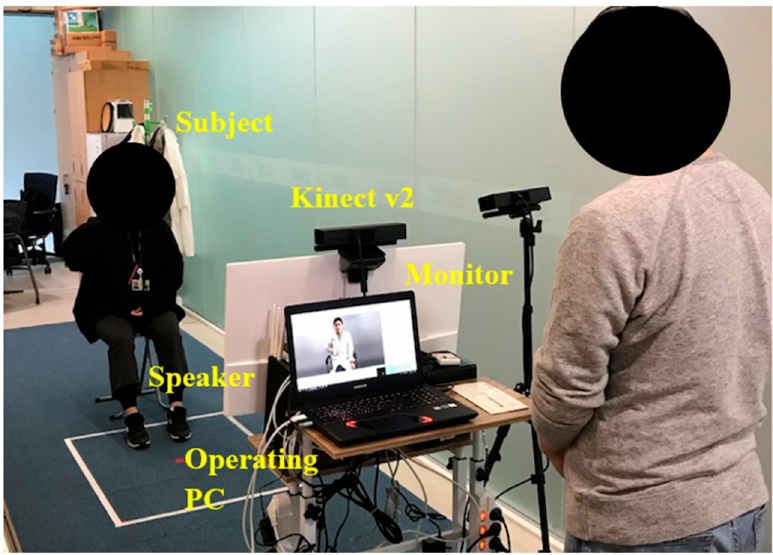
Figure 3. Experimental setup. Note that another Kinect that is located beside the monitor was just used to record depth images during FMA tests.